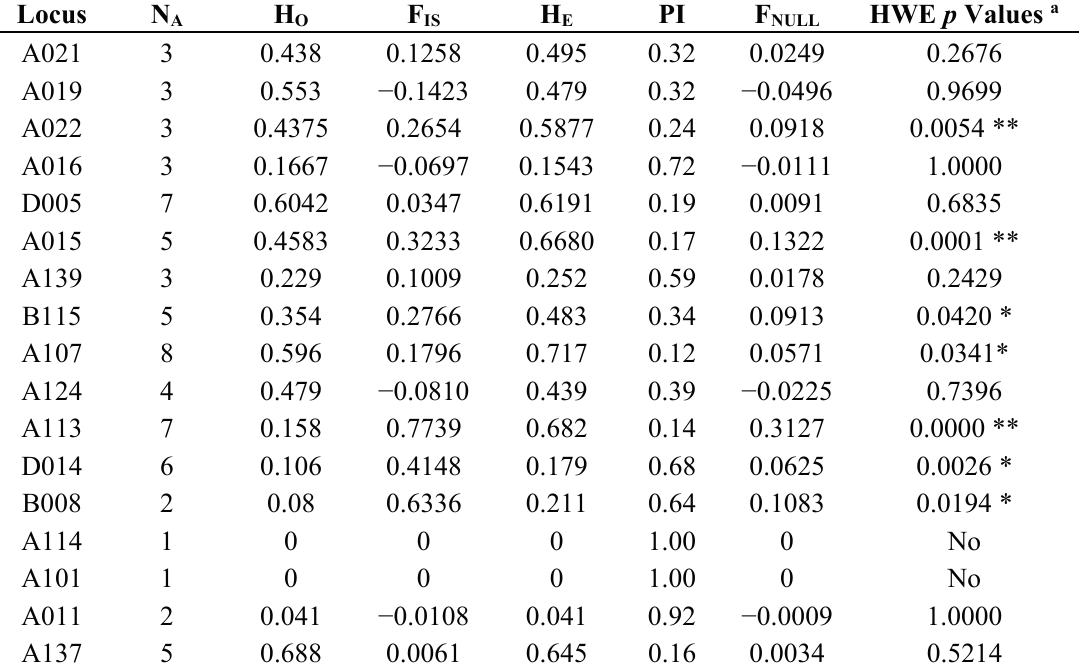
Table 4. Basic statistics of 21 microsatellites loci developed for E. autumnata in a survey of 48 individuals from Northern